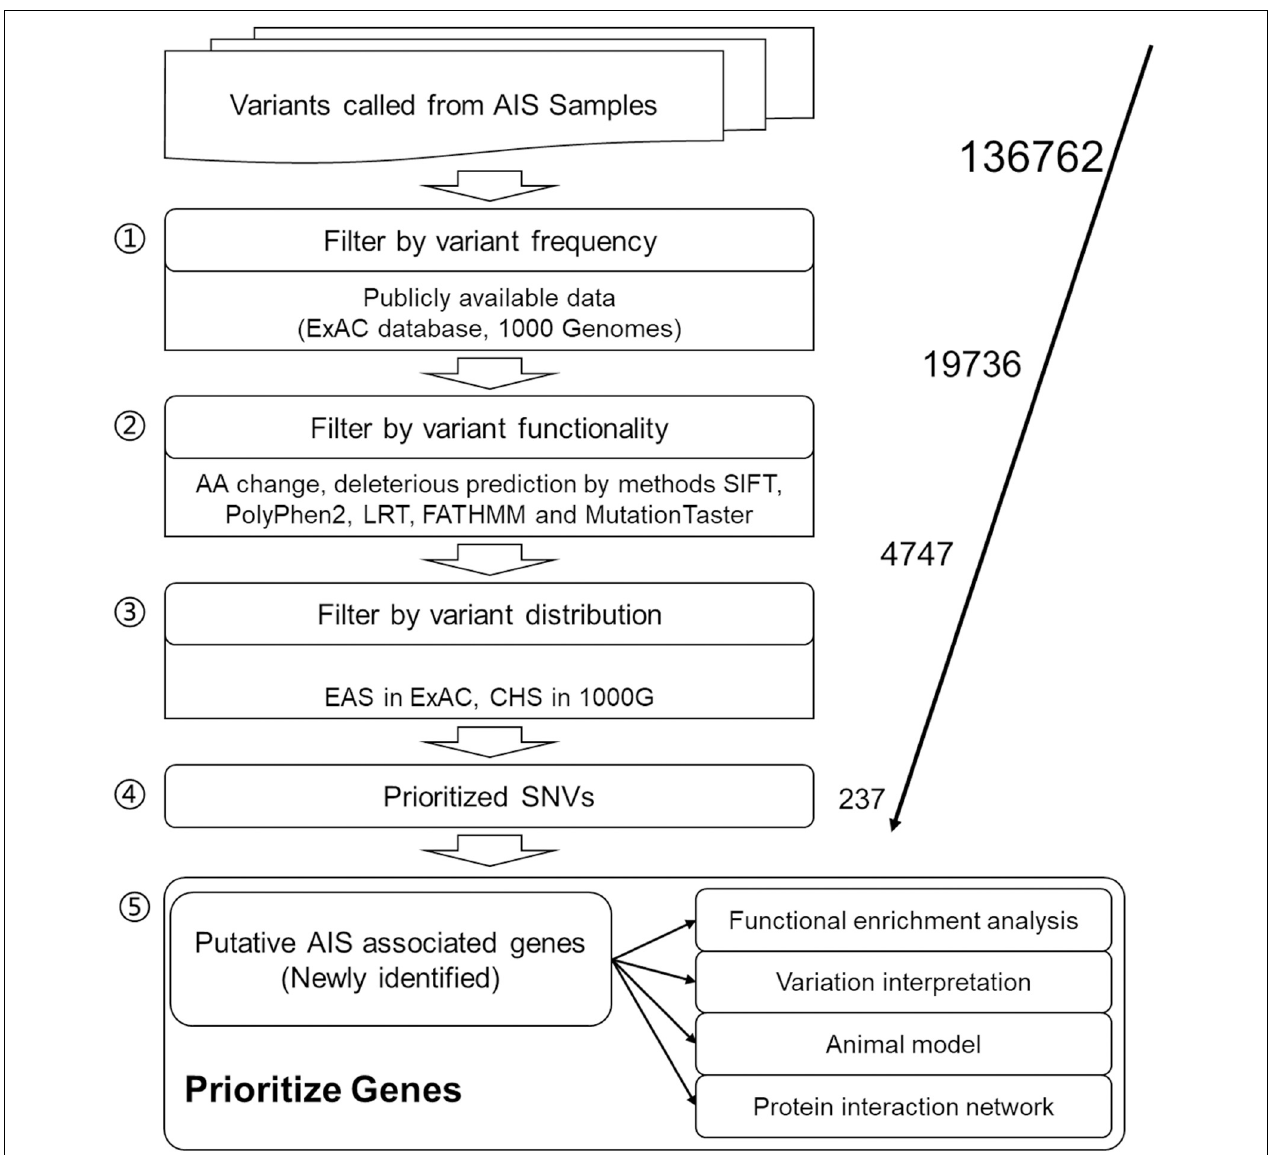
FIGURE 1 | Workflow of adolescent idiopathic scoliosis (AIS) associated variant